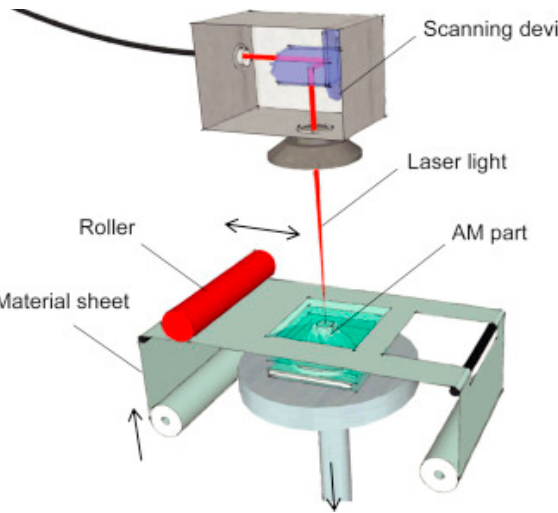
Figure 9. Laminated object manufacturing (LOM) process (adapted with permission from reference